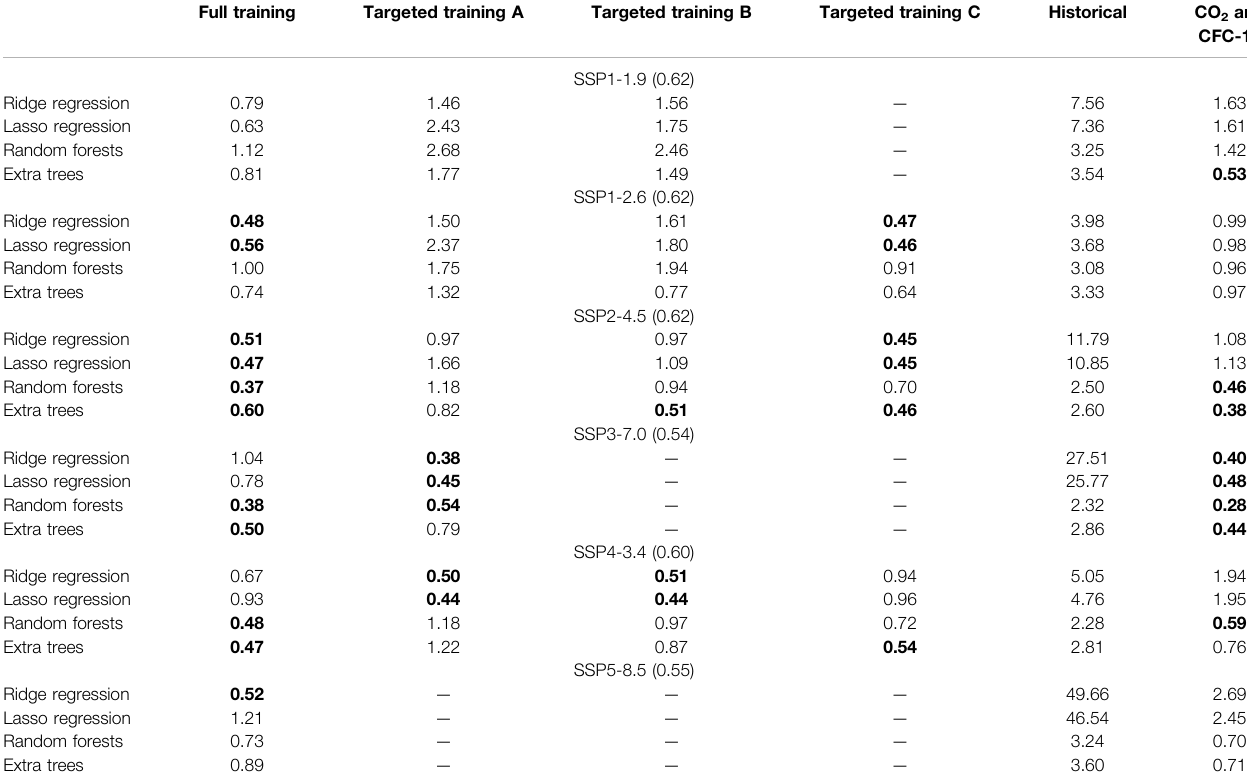
TABLE1| Rootmeansquareerror(RMSE)forprojectionsmadeusingthefourdifferentmachinelearningmethods,comparedtotheUKESM1ensemblemeanforeachSSP scenario for different training conditions.